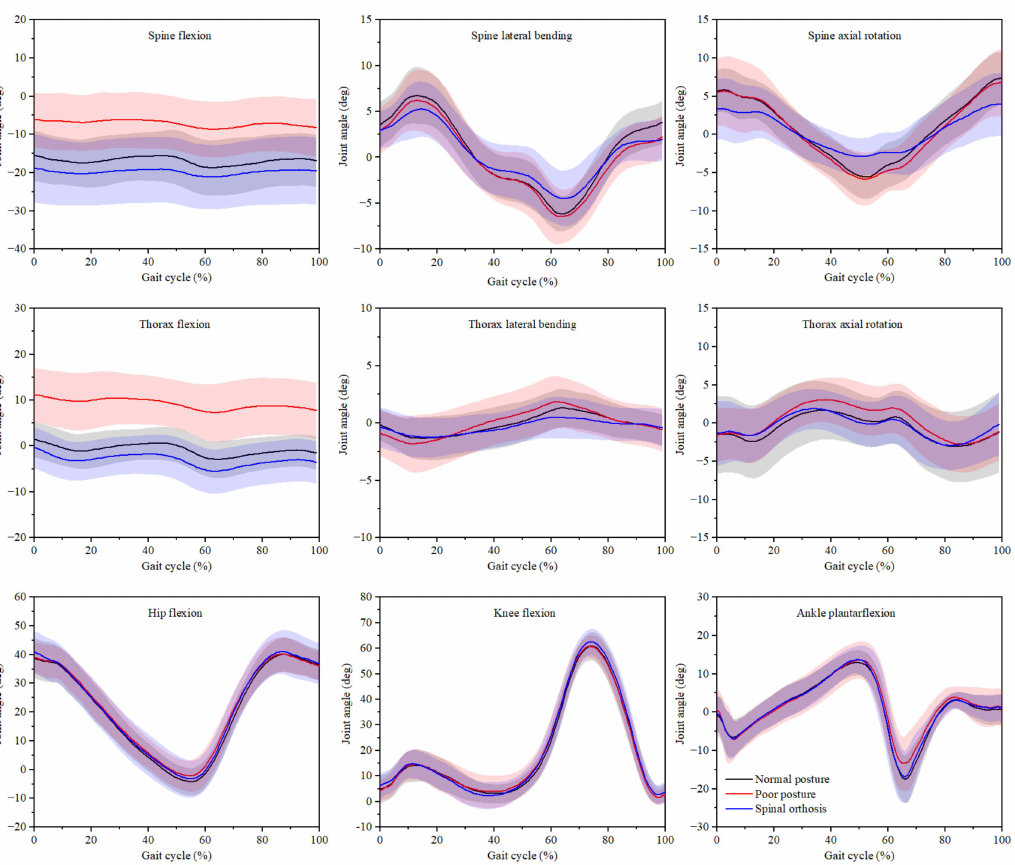
Figure 4. Joint angles (mean and standard deviation) of the trunk and lower extremity joints during the gait cycle when walking in normal posture, poor posture, and spinal orthosis.